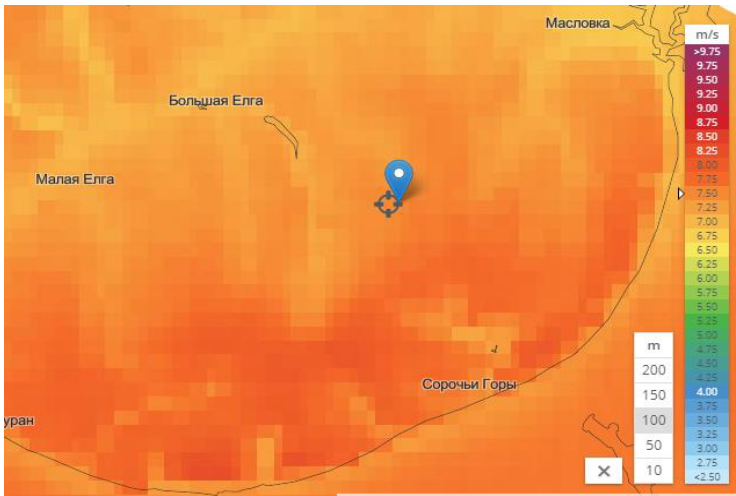
Figure 3. Map presenting the mean wind speed in Sorochi Gory